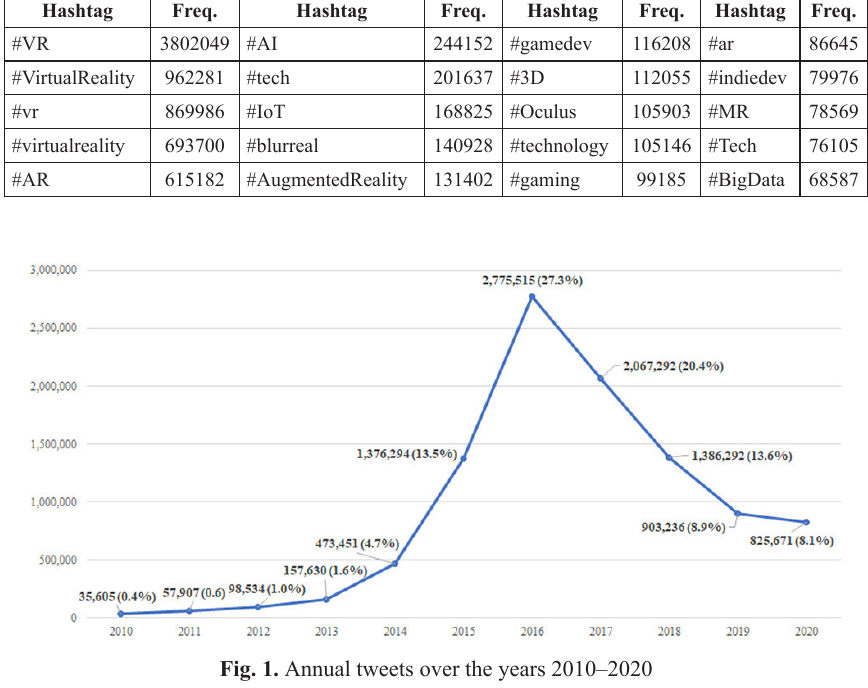
Fig. 1. Annual tweets over the years